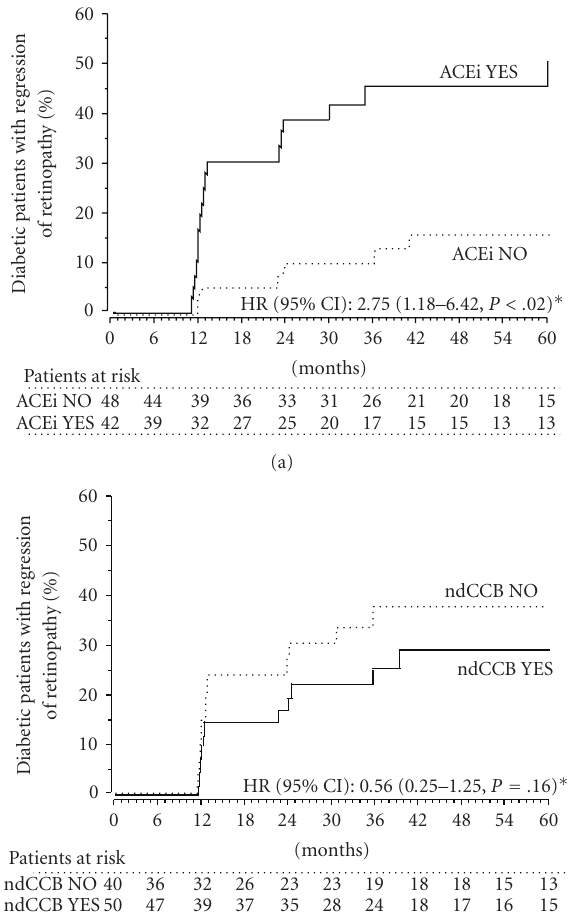
Figure 3: Cumulative incidence of patients with retinal involve- ment at baseline who achieved regression of diabetic retinopathy according to randomization to ACEi therapy YES or NO (a) or to ndCCB therapy YES or NO